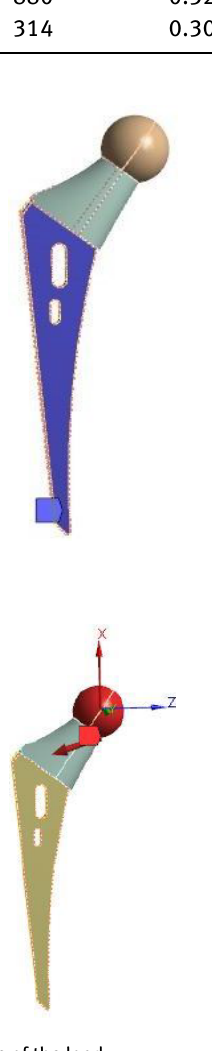
Figure 5: The magnitude of the